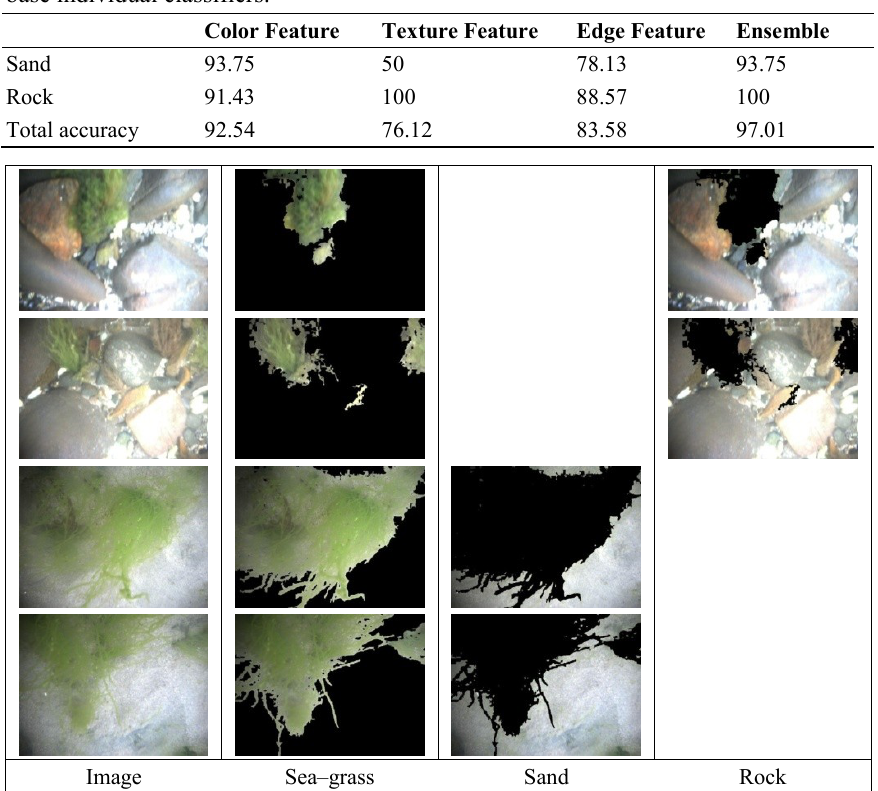
Table 4. Maximum test set accuracies obtained by the ensemble and corresponding base individual classifiers.